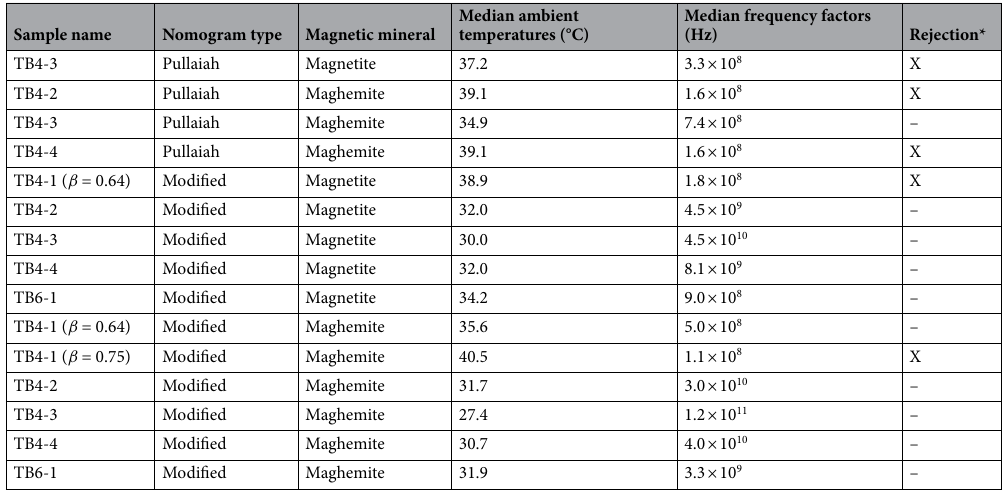
Table 2. Parameters selected for Meiwa tsunami boulders. * ‘X’ is the rejected data and ‘–’is the accepted